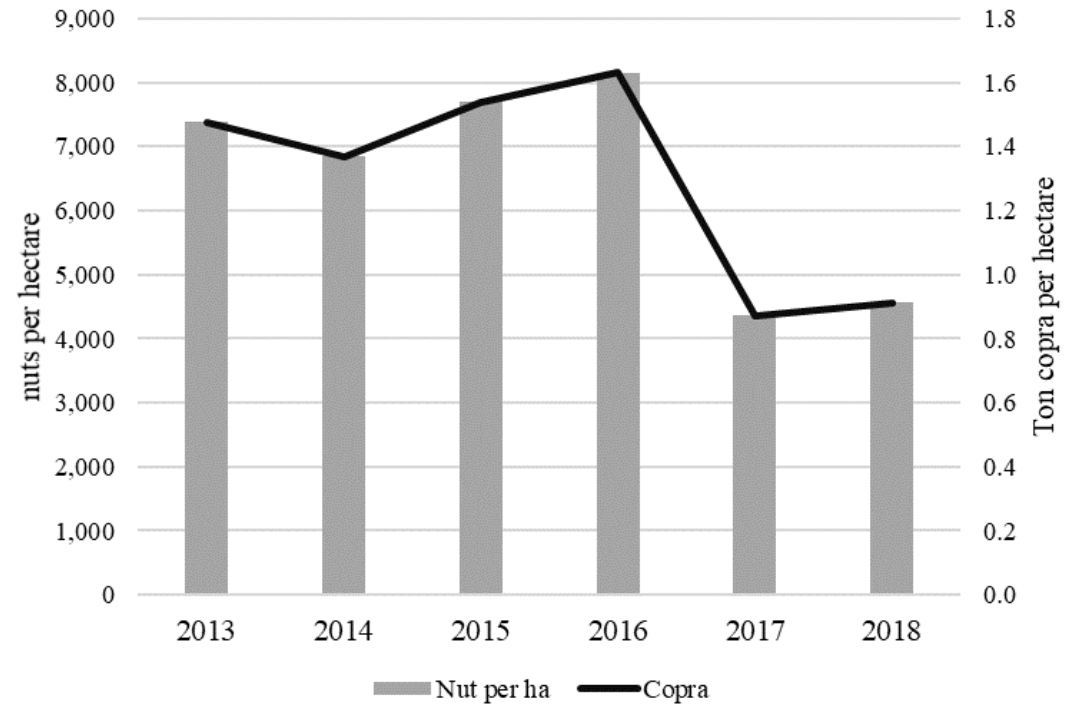
Figure 6. Coconut productivity in the Pulau Burung coconut plantation over six